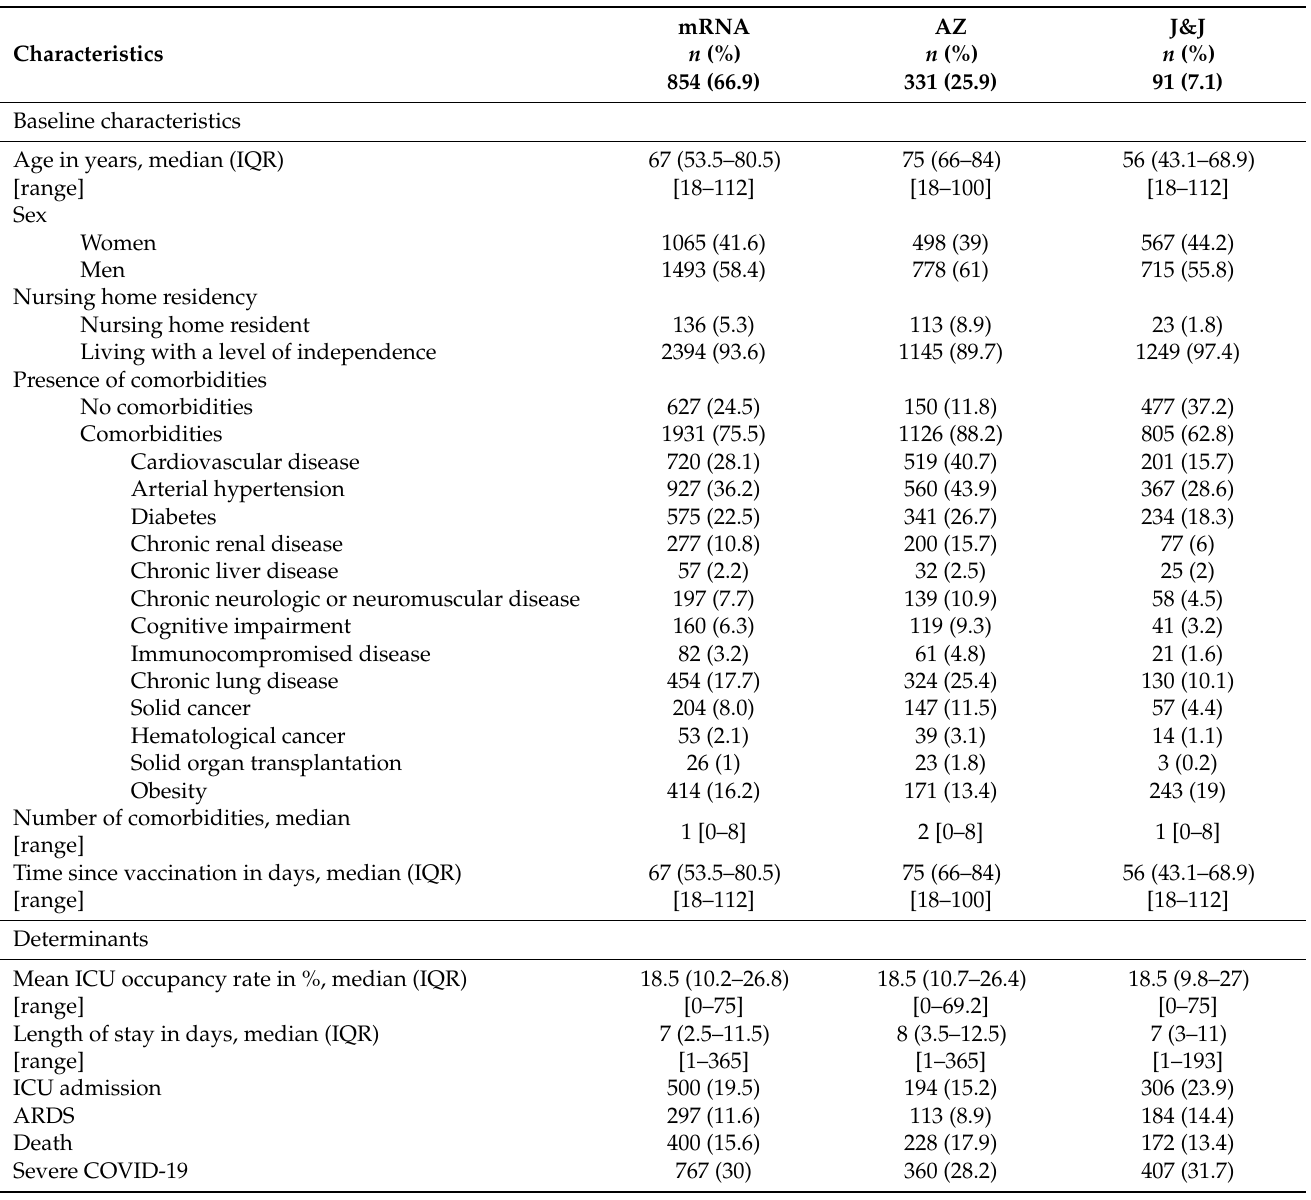
Table A2. Description Delta breakthrough cases subcohort before exclusion of losses-to-follow-up.